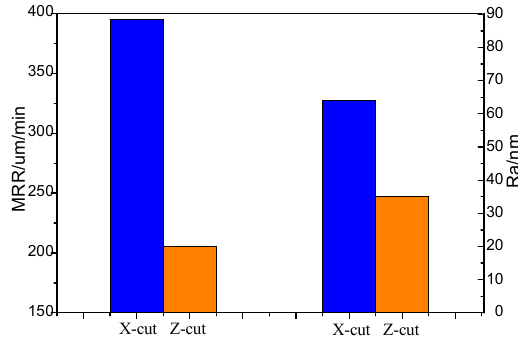
Figure 12. MRR and Ra of Z-cut and X-cut.